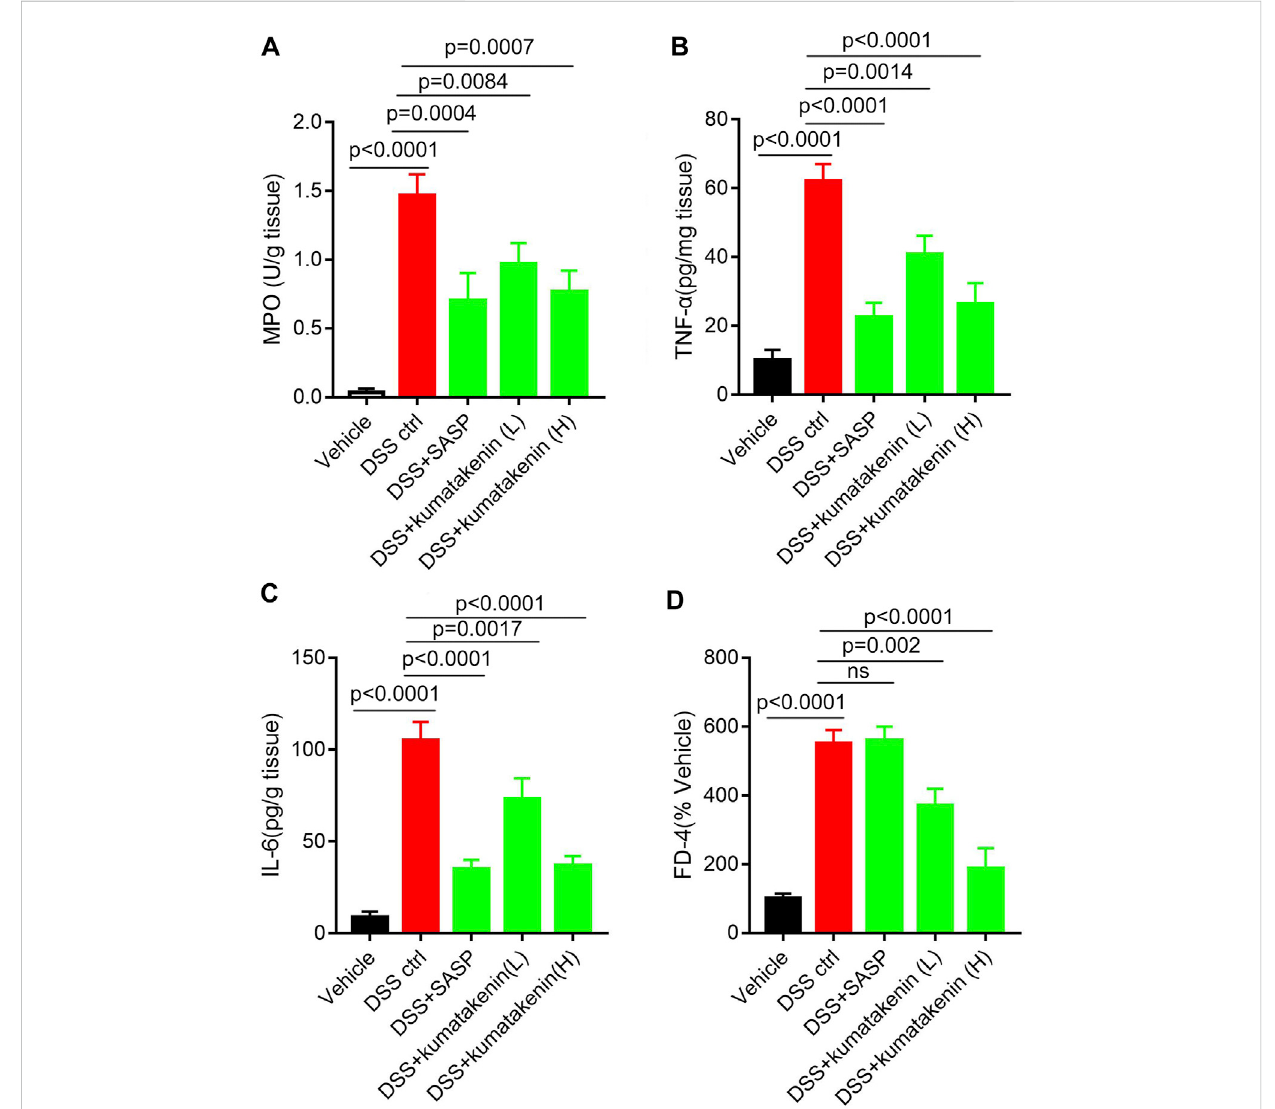
Effects of kumatakenin on colonic in fl ammation and epithelial barrier function in colitis mice. Mice with colitis were gavaged with kumatakenin (25 mg/kg/day; 100 mg/kg/day) for 9 days and (A) colonic MPO level, (B,C) pro-in fl ammatory cytokines (TNF- α and IL-6) and (D) serum fl uorescein isothiocyanate-dextran (FD-4) levels were measured. SASP, sulfasalazine; kumatakenin (L), 25 mg/kg kumatakenin; kumatakenin (H), 100 mg/kg